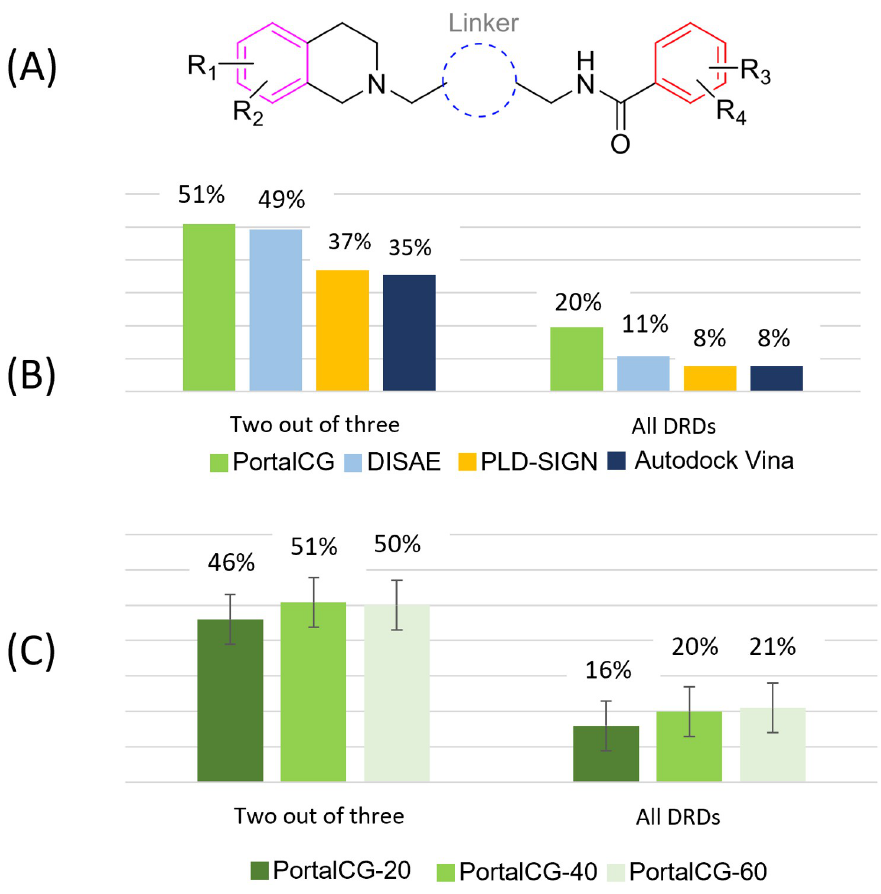
Fig 4. Performance comparison of PortalCG with the state-of-the-art methods for designing selective dual-DRD antagonists. (A) The chemical scaffold on which 65 compounds were synthesized as potential selective dual-DRD1/ DRD3 antagonists. Tens of thousands of chemicals can be generated from the different combination of four functional groups R1, R2, R3, and R4 and a linker group. (B) The prediction accuracy of DRD binding profile classification. Note that a significant difference between PortalCG’s performance relative to the next-best method (DISAE) emerges in a task involving correct prediction of all three DRDs (right-hand side), versus just two of the three (DRD1, DRD2, and DRD3). (C) The performance of PortalCG when sequence similarities between the proteins in the training/validation set and DRD1/DRD2/DRD3 were less than 20%, 40%, and 60%, respectively. The performance was measured by the accuracy of a three-label classifier. “Two out of three” and “all DRDs” represented the accuracy when two labels and all three labels were predicted correctly.